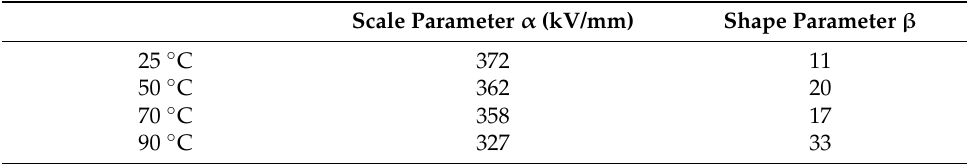
Figure 10. Weibull distribution of breakdown strength of PP at different temperatures. Table 2. Parameters for breakdown strength.